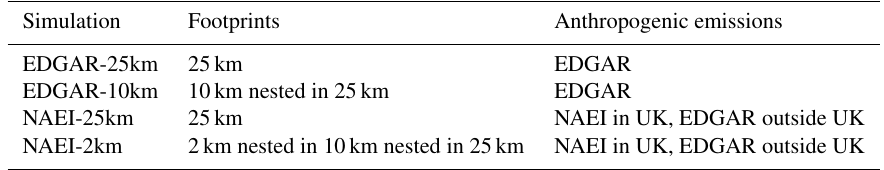
Table 2. Summary of atmospheric CH 4 simulations. WetCHARTs and GFED4 were used for wetland and biomass burning emissions in all simulations.